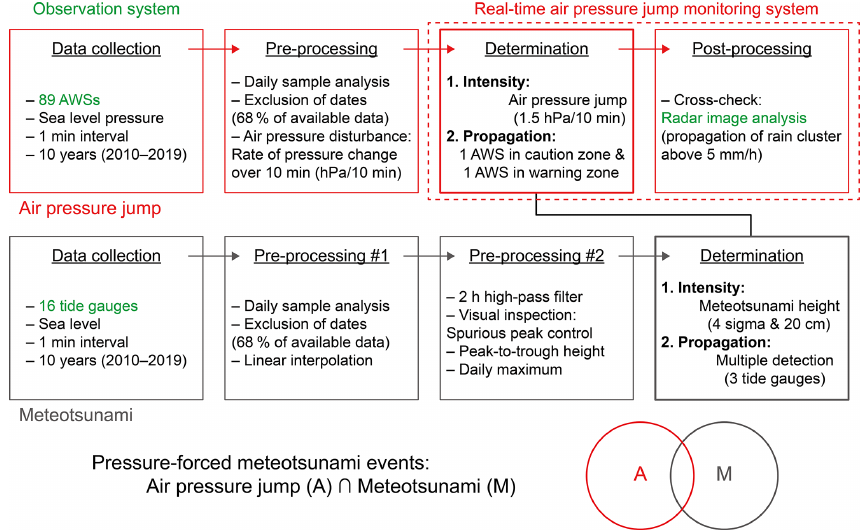
Figure 3. Process flow diagram showing classification of pressure-forced meteotsunami events.